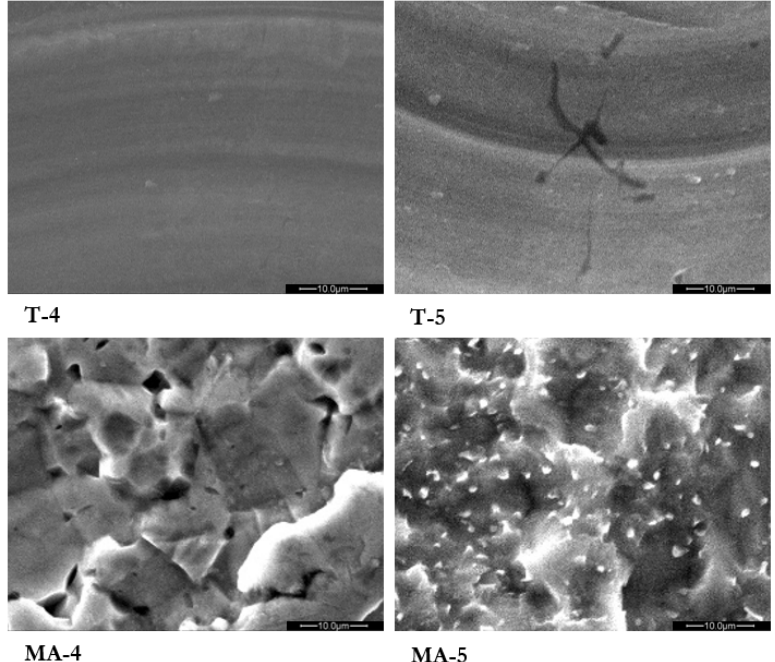
Figure 1. Turned grade 4 ( T-4 ), turned grade 5 ( T-5 ), mildly acid-etched grade 4 ( MA-4 ), and mildly acid-etched grade 5 ( MA-5 ) Ti surfaces analyzed by scanning electron microscopy (SEM). Magnification 2500×.